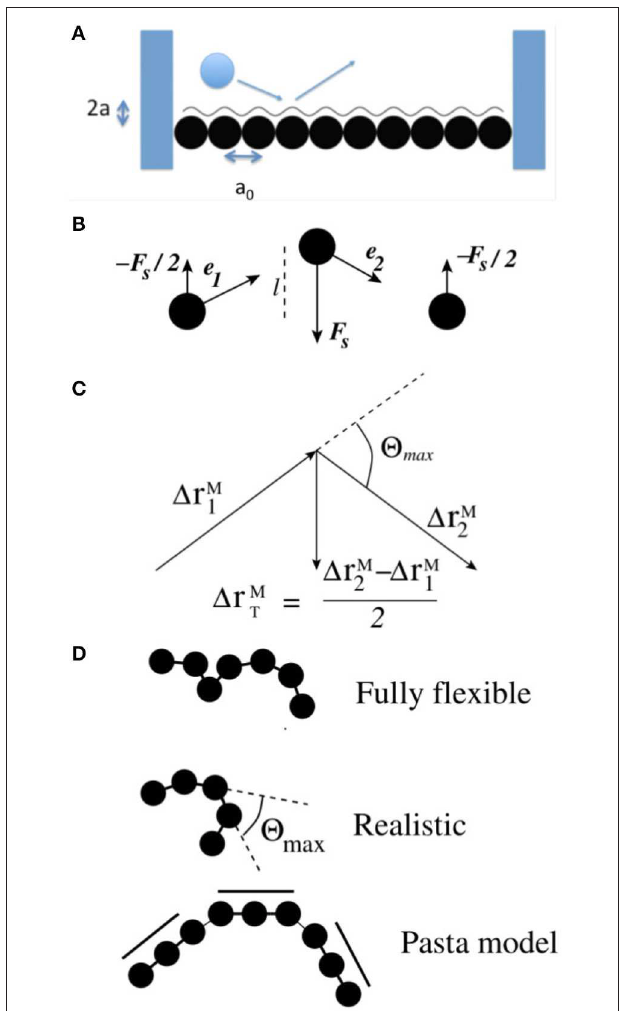
FIGURE 5 | (A) Model of the bead packing in terms of a rough bottom. (B) The stiffness force is distributed so that the total force vanishes. (C) The transverse displacement vector 1 r M T when 2 = 2 max . (D) The various simulated chains with differing internal stiffness interactions. Adapted from Flekkøy et al. [10] with permission from the